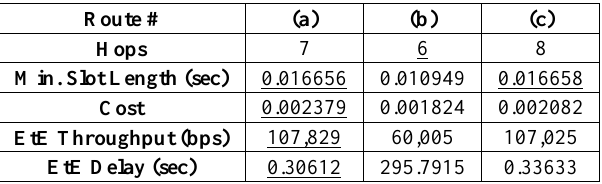
Table 1. Cost comparison of the example paths in Figure 2 Route #